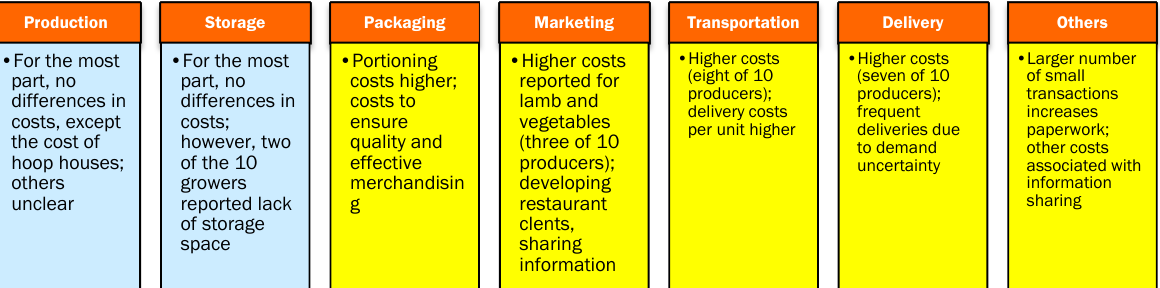
Figure 2. Associated Costs of the Resultant Value Chain